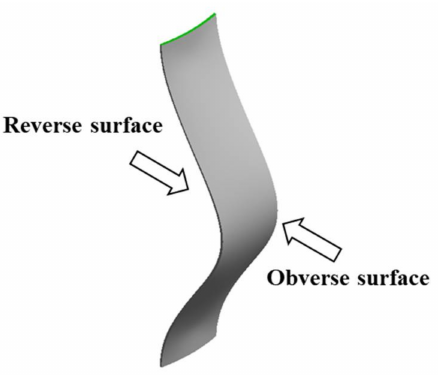
Figure 11. The schematic drawing of two types of buckling surface for a tape-shaped SMA element with curvature of the